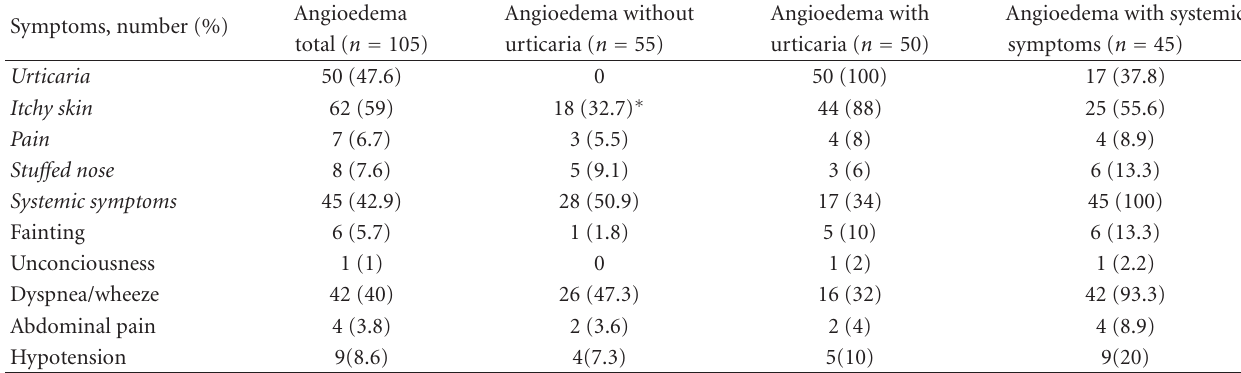
Table 2: Signs and symptoms associated with